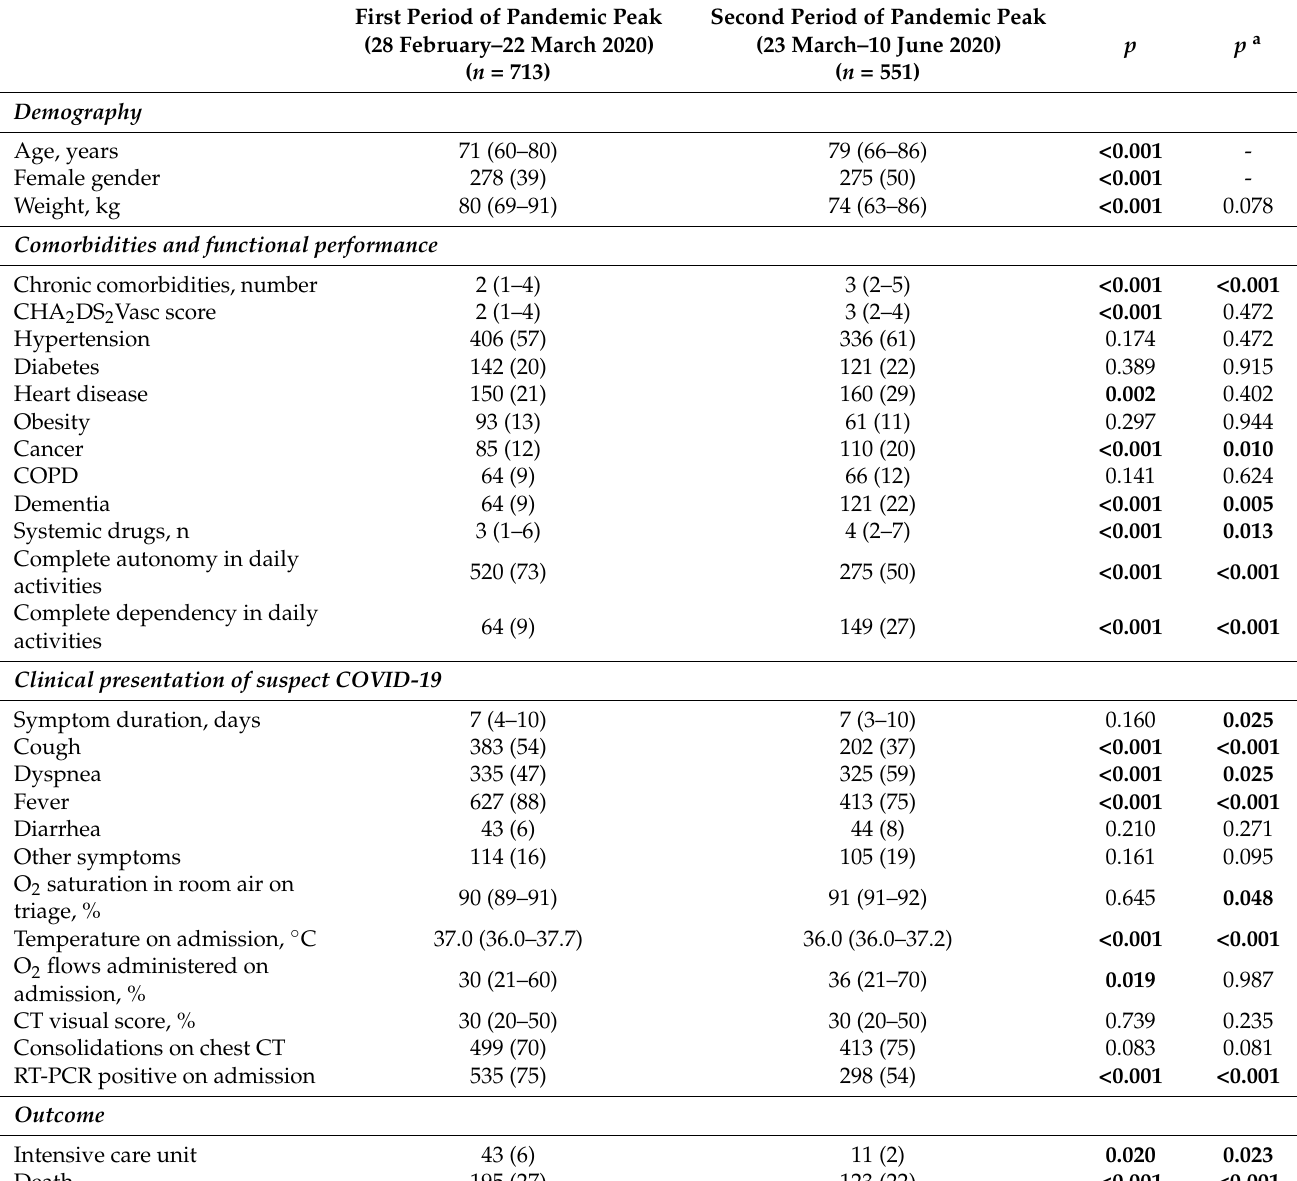
Table 1. Comparison of the demographic, anamnestic, clinical features, and outcomes of patients hospitalized during different periods of the pandemic